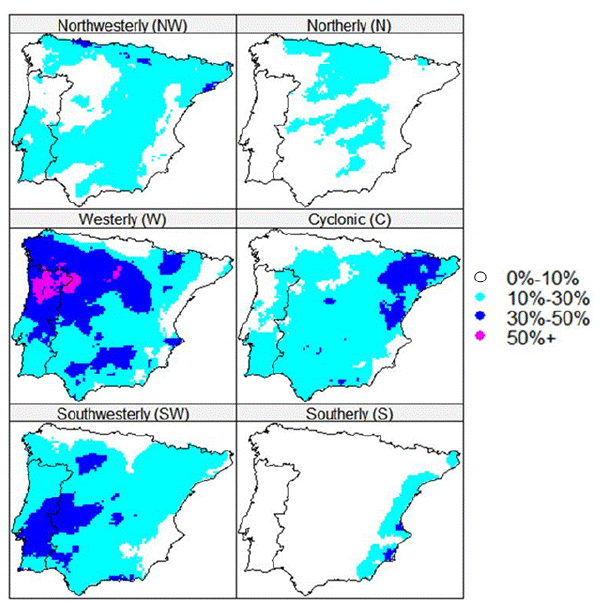
Figure 8. Spatial and temporal relative contribution to total January precipitation for NW, N, W, C, SW and S WTs. Fig. 8. Spatial distribution of the relative contributes to total January precipitation for NW, N, W, C, SW and S